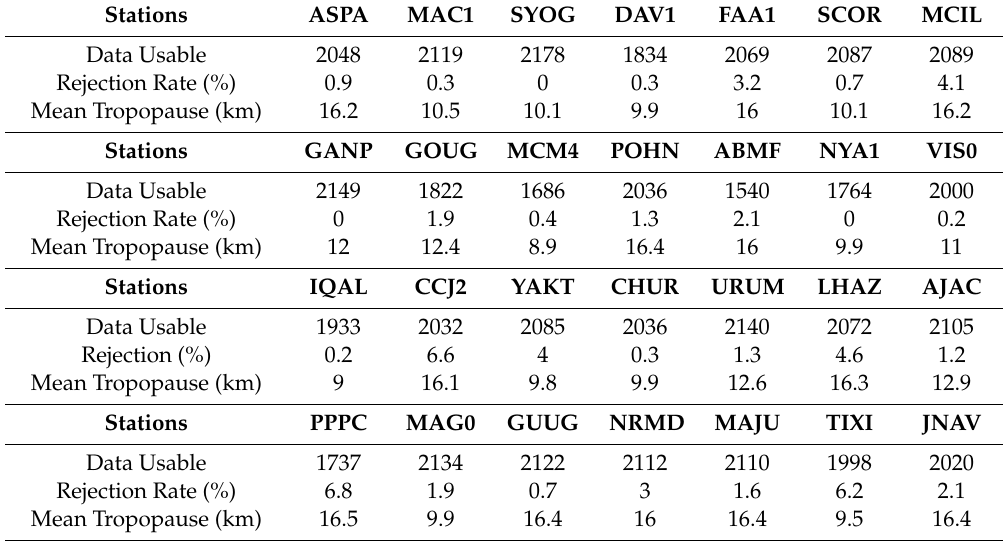
Table 3. Radiosonde data rejection rates using mean tropopause height estimates for all the 28 stations of this study (see Figure 2 for the definition of the mean tropopause